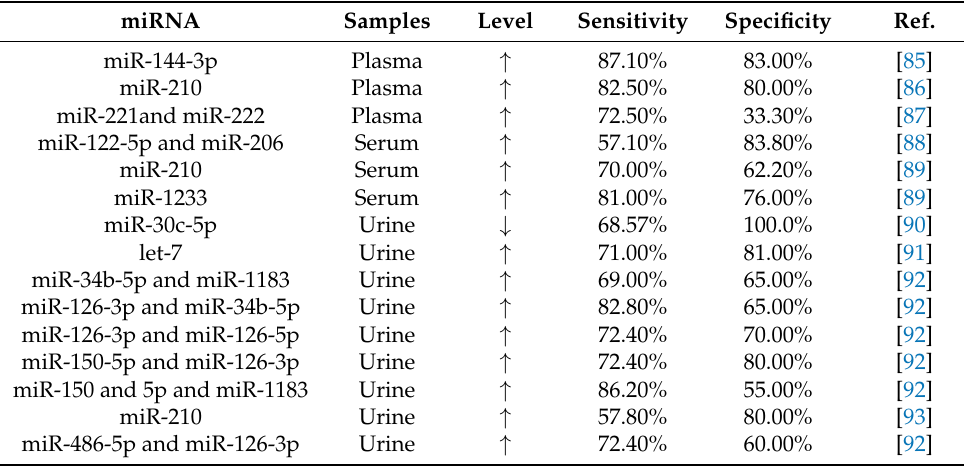
Table 2. miRNAs and their diagnostic potentials in renal cell